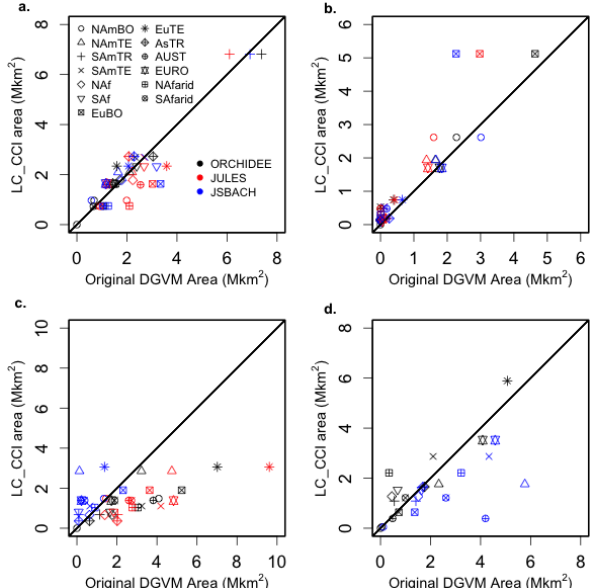
Figure 6. Regional correlations between the original ESM PFT coverage and the LC_CCI, epoch 2008–2012, coverage for (a) broadleaf trees, (b) needleleaf trees, (c) natural grasslands and (d) managed grasslands. The regions follow the TRANSCOM ex- periment biome boundary definitions, which partition terrestrial ecosystems into 13 regions of similar vegetation (see Appendix